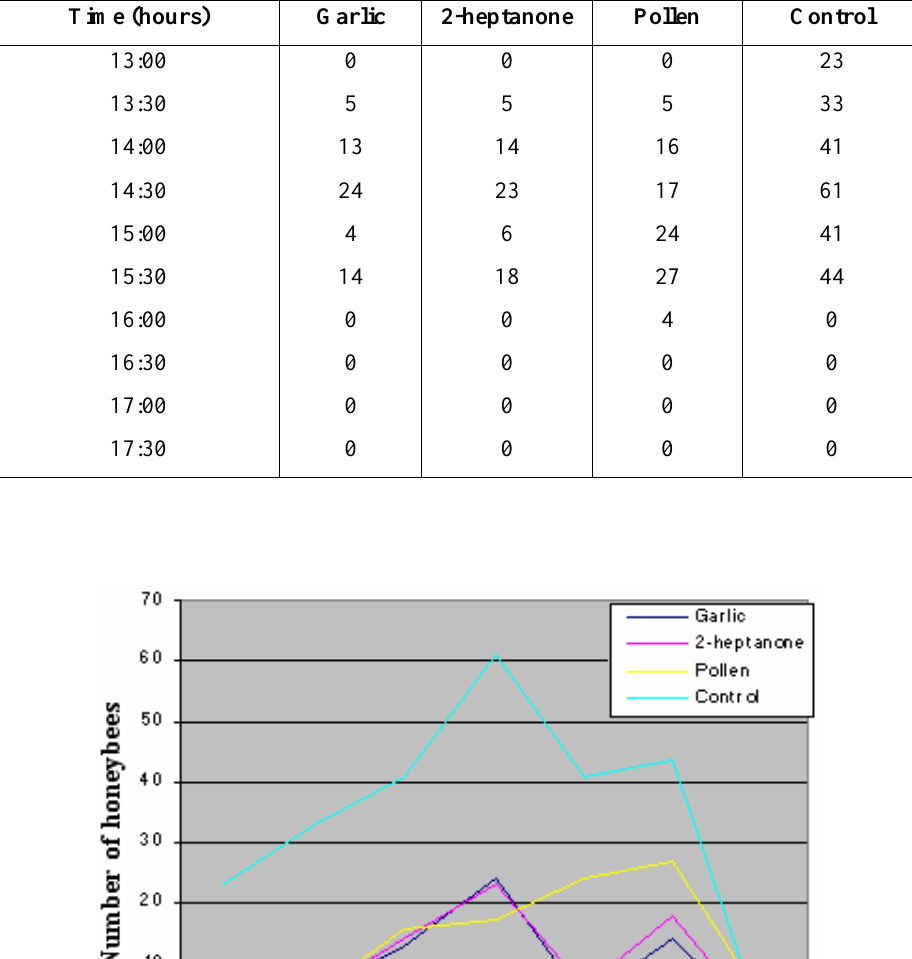
Table 2 . Average number of honeybees in passion-fruit flowers in the 4 treatments from